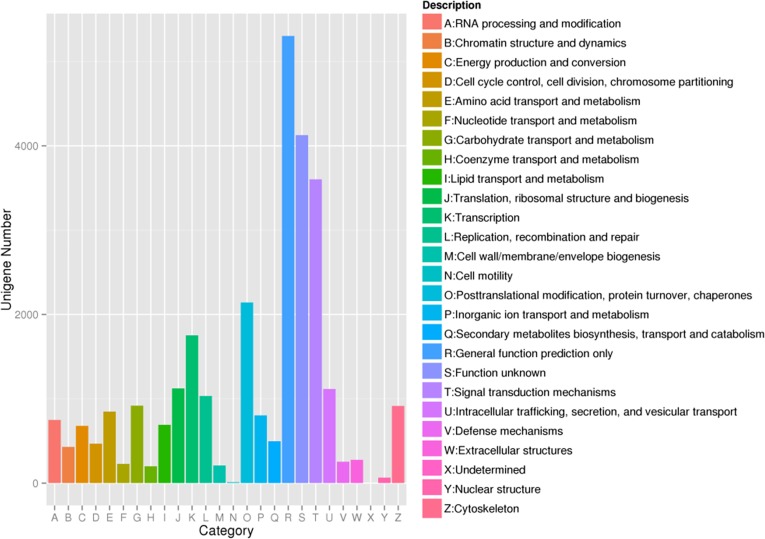
Clusters of eggNOG functional classification of P. trituberculatus transcriptome.